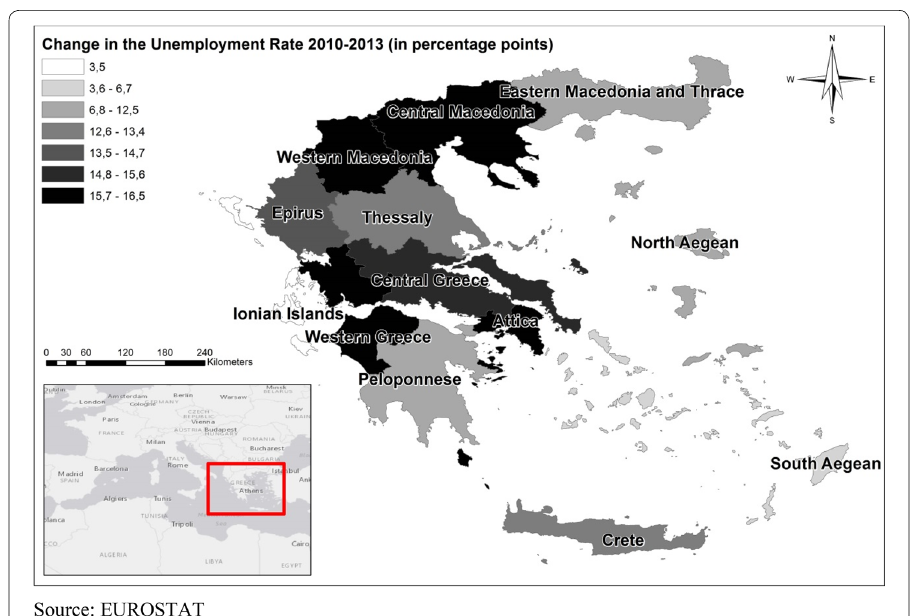
Fig. 1 Change in regional unemployment rate: Greece,